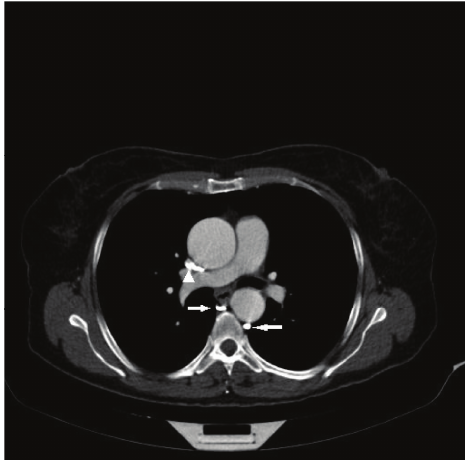
Figure 4: The left azygos vein was developing the left aspect of the arcus aorta (arrow).